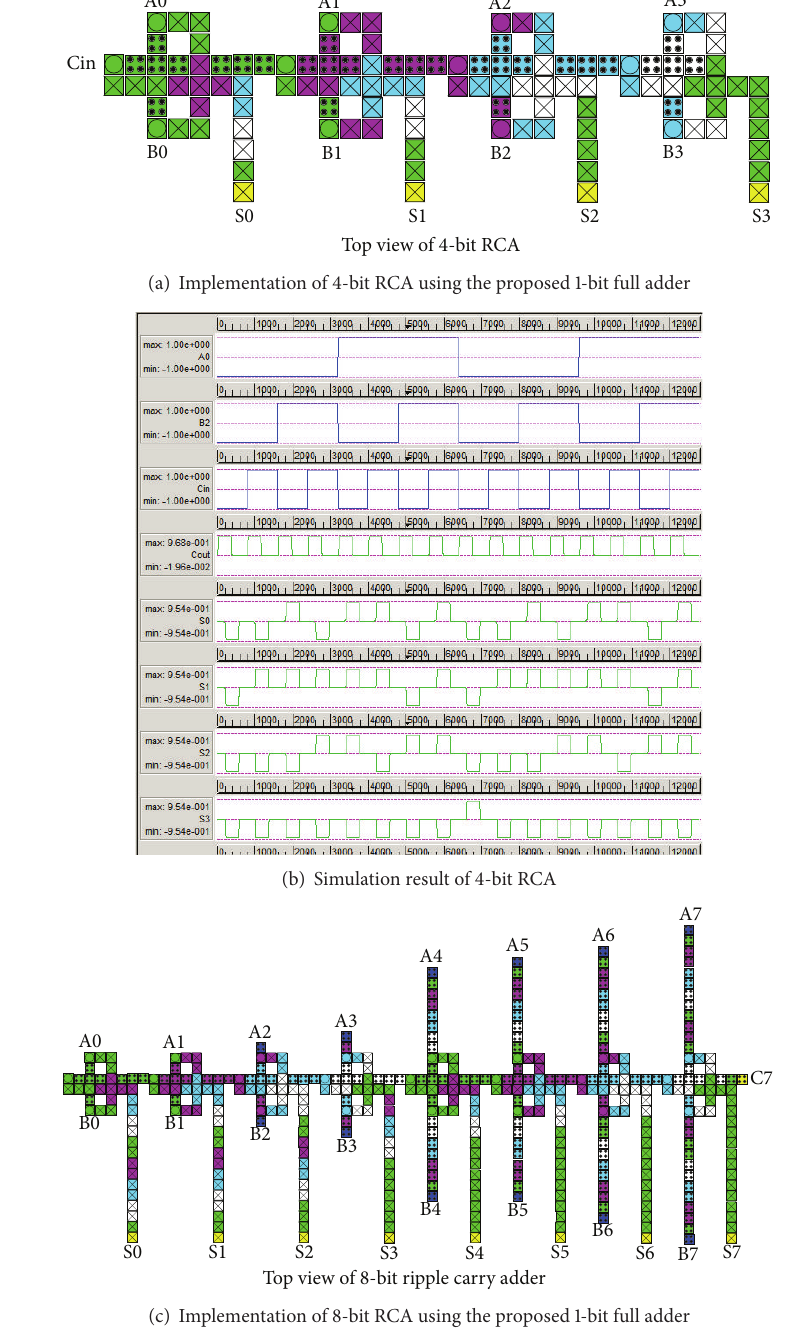
Figure 9: QCA implementation of different ripple carry adder (RCA) circuits with the proposed 1-bit full